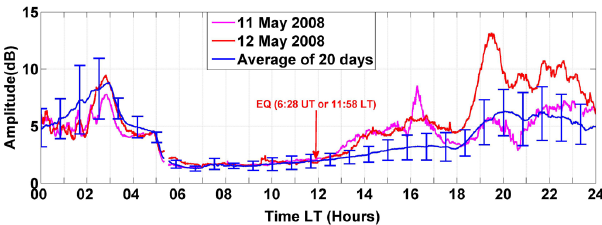
Fig. 3. Comparison of 11 and 12 May 2008 VLF amplitude en- hancement with average of 20 days. Arrow indicates EQ timing in UT and LT on 12 May 2008.